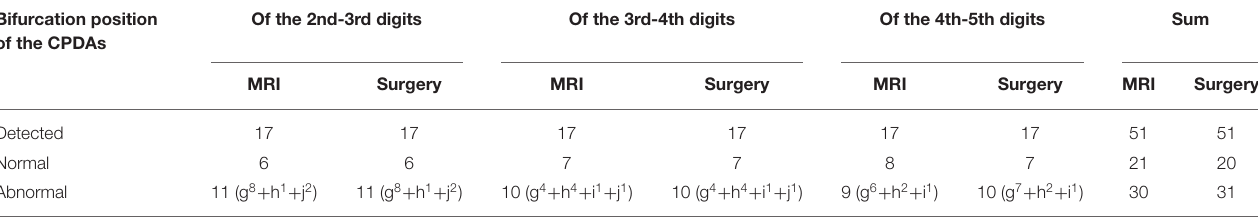
TABLE 2 | Comparison of the bifurcation position of the CPDAs as shown by CE-3D-WATSc and surgical observation in patients with CSM ( n = 51). Bifurcation position Of the 2nd-3rd digits Of the 3rd-4th digits Of the 4th-5th digits of the CPDAs